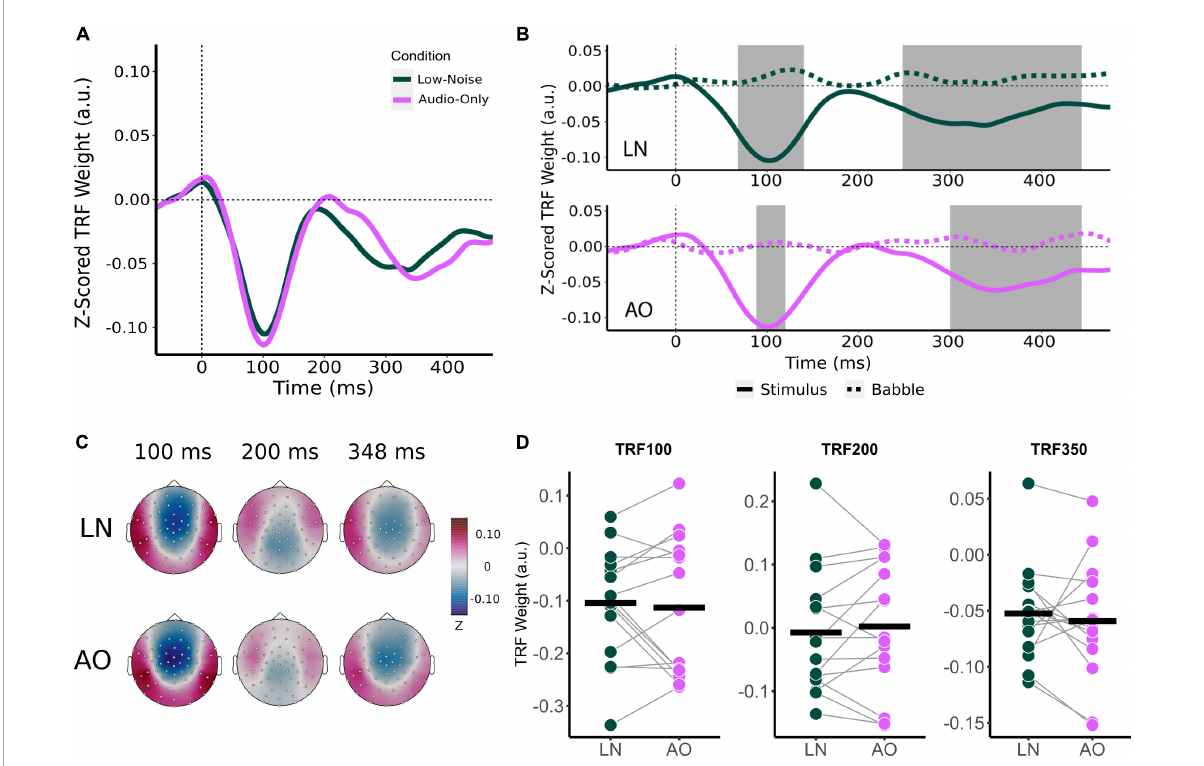
FIGURE5 Effect of visual cues on sensor-level TRF peaks. (A) Mean condition TRFs compared between the audiovisual Low-Noise (LN) and Audio-Only (AO) conditions. (B) Mean stimuli (solid-line) and background noise (dotted-line) TRFs are compared for each condition (LN—top; AO—bottom) using paired t -tests. Shaded regions indicate time intervals where the TRFs were significantly different after correcting for multiple comparisons. (C) Topographies of the mean condition stimuli TRFs at the 100, 200, and 350 ms time lags. (D) TRF peaks were compared between the LN and AO conditions. Black horizontal bars indicate the mean TRF weight of each condition. No significant differences were observed.